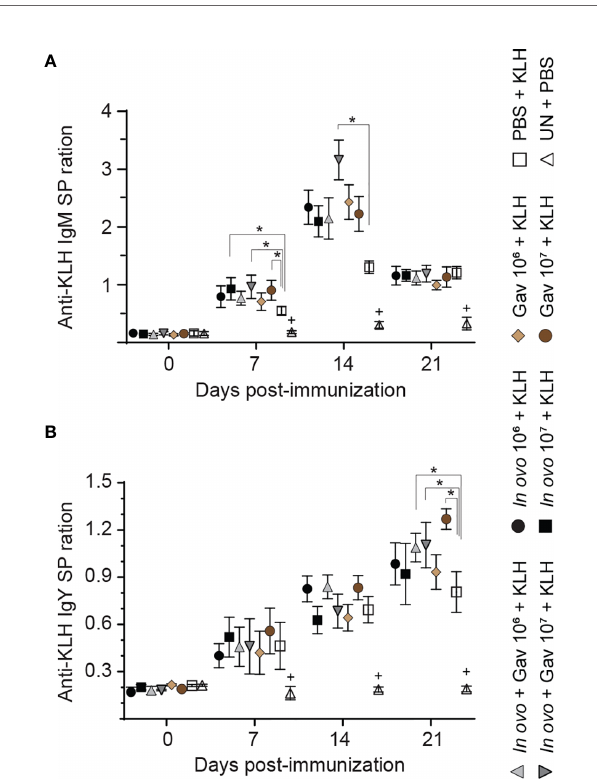
FIGURE 8 | Serum anti-KLH antibodies titers as a measure of immune competence. Serum anti-KLH IgM (A) and IgY (B) titers were determined by indirect ELISA. Serum samples were collected post-hatch from chickens immunized with KLH and pre-treated with a lactobacilli cocktail as follow: groups 1 and 2 received 10 6 and 10 7 CFUs of lactobacilli cocktail in ovo , respectively, at embryonic day eighteen; groups 3 and 4 received 10 6 and 10 7 CFUs of lactobacilli, respectively, via both in ovo and oral gavage (on days 1, 7, 14, 21, 28 post-hatch); groups 5 and 6 received 10 6 and 10 7 CFUs of lactobacilli, respectively, via oral gavage; group 7 was injected with phosphate-buffered saline (PBS); group 8 remained untreated (UN). On days 14 and 21 post-hatch, birds were immunized intramuscularly with 100 m g KLH in 0.25 ml PBS. The untreated group (UN) was inoculated intramuscularly with 0.5 ml of PBS and served as the negative control. Statistical signi fi cance among treatment groups was calculated using SAS Proc GLM (General Linear Model) followed by Tukey ’ s comparison test. Error bars represent standard errors of the mean. Results were considered statistically signi fi cant if P < 0.05. Bars with asterisks represent a signi fi cant difference among treatments. The data are representative samples from 12 individual